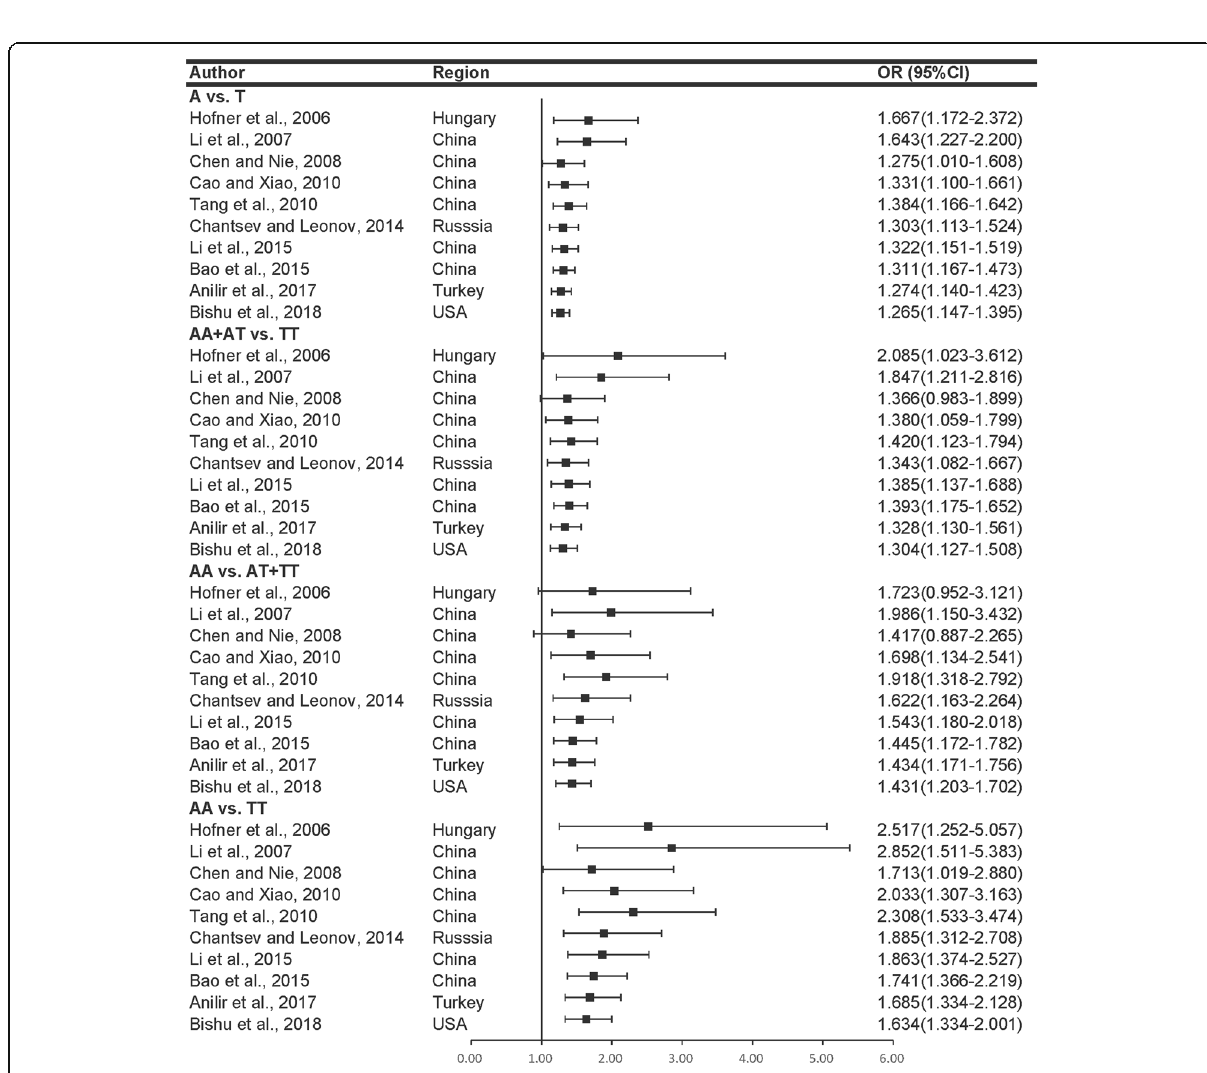
Fig. 2 Cumulative meta-analysis describing the association between IL-8 rs4073 variant and AP in four genetic models. The results indicated there is a consistent trend toward association after the initial